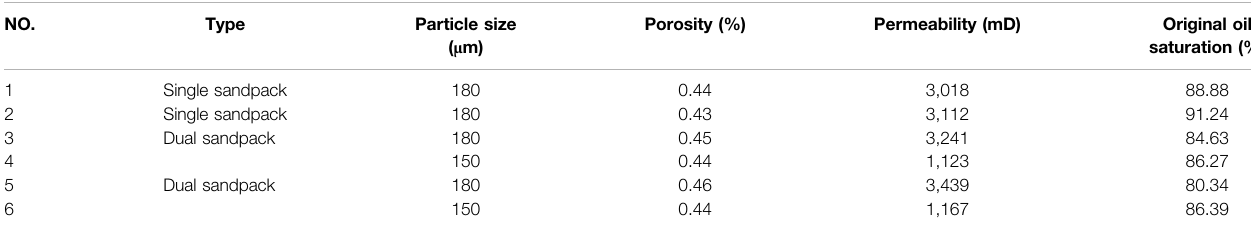
TABLE 2 | Sandpack parameters of single sandpack/dual sandpack.